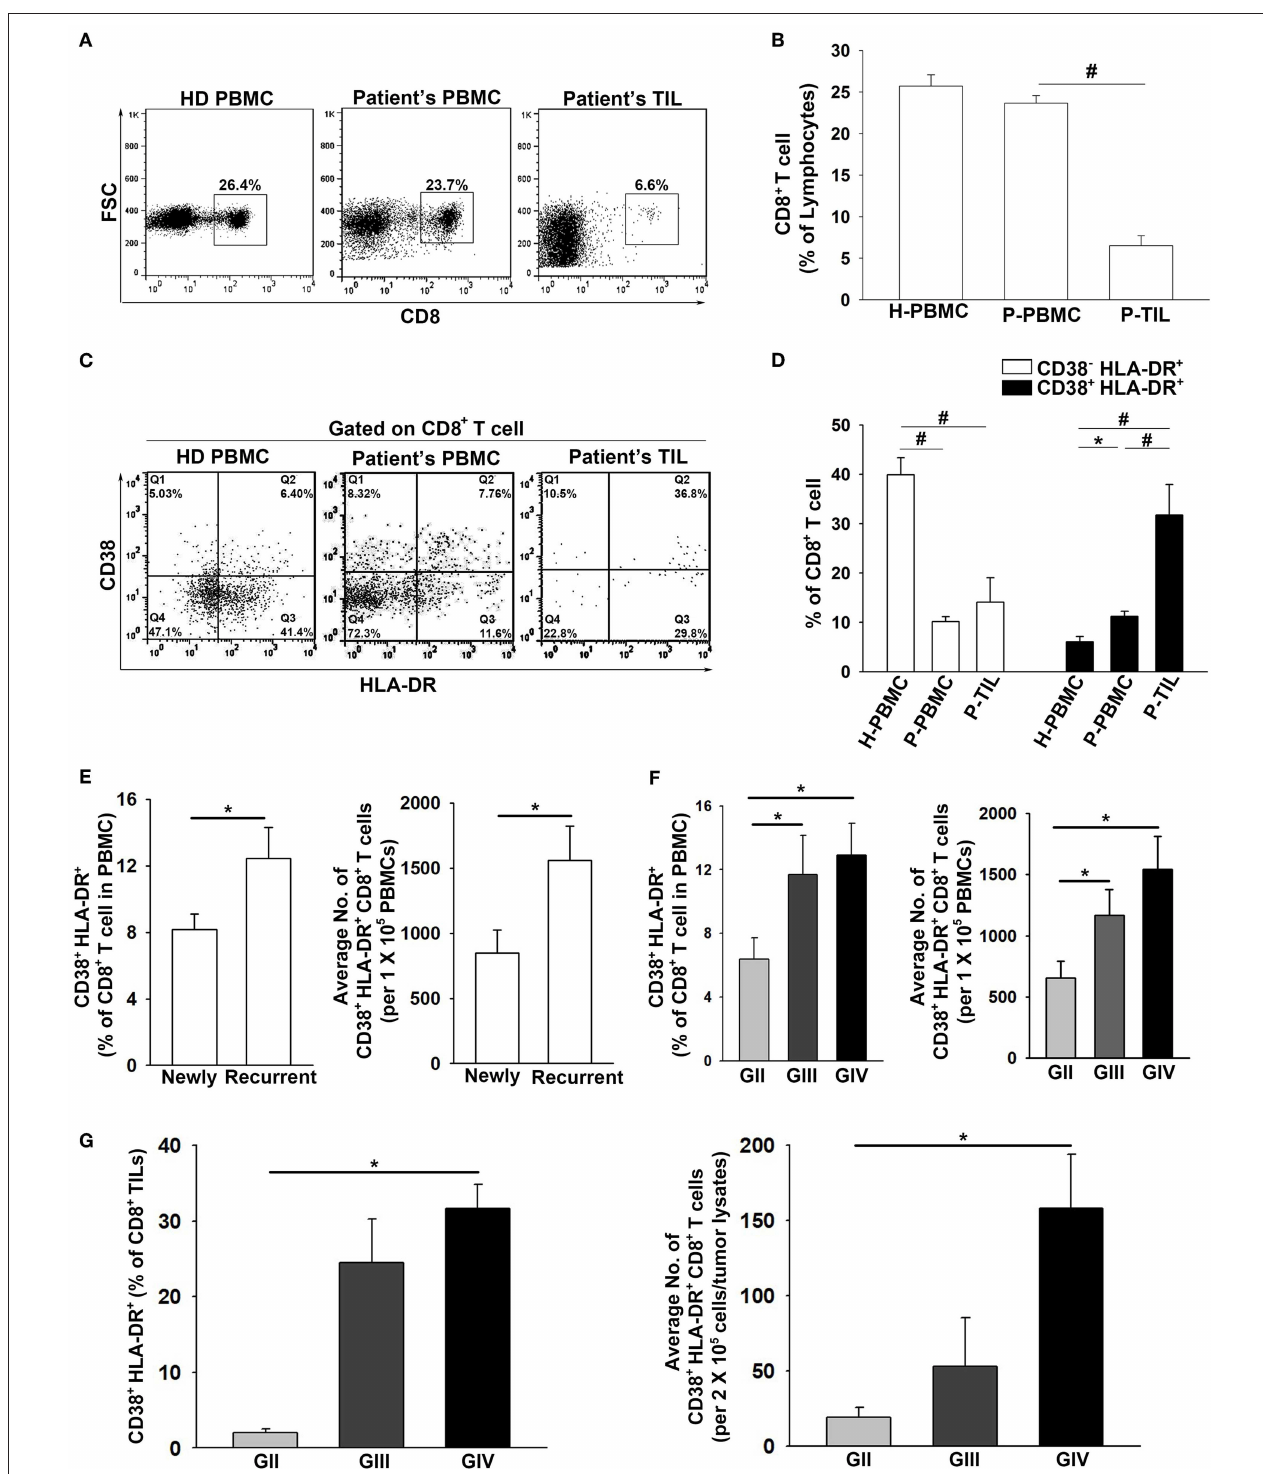
FIGURE 2 | Pronounced activation and penetration of CD38 + HLA-DR + CD8 + T cells in high-grade glioma. (A,B) The overall expression percentage of CD8 + T cells was significantly lower in Patient TILs ( n = 17) than in Patient PBMCs ( n = 117) and healthy donors (HD PBMC; n = 31). (C,D) The expression percentage of CD38 − HLA-DR + CD8 + cells was higher in HD PBMCs (H-PBMCs) than in Patient PBMCs (P-PBMCs) and TILs (P-TILs); profound CD38 + HLA-DR + CD8 + T-cell activation was observed in P-PBMCs and P-TILs. (E) The expression of CD38 + HLA-DR + CD8 + T cells in newly-diagnosed ( n = 59) and recurrent ( n = 58) patients. (F) The expression of CD38 + HLA-DR + CD8 + T cells in the PBMCs of GII ( n = 22), GIII ( n = 17), and GIV ( n = 51). (G) The expression of CD38 + HLA-DR + CD8 + TILs in the gliomas of GII ( n = 3), GIII ( n = 5), and GIV ( n = 9). Values shown are means ± SEM (bars); * p < 0.05, # p < 0.01 by Student’s t- test.